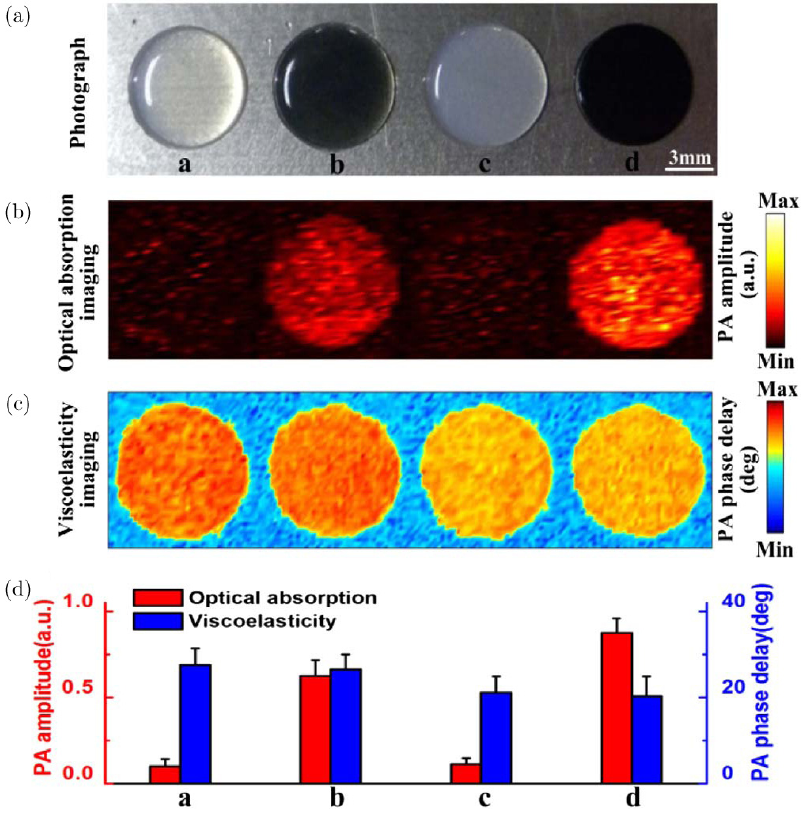
Source : Reproduced with permission from Ref. 43. Fig. 3. (a) Photograph of the imaging samples. (b) Optical absorption image and (c) viscoelasticity image of the tissue-mimicking phantoms. (d) The averaged amplitude and phase delay of the PA signal from each phantom.